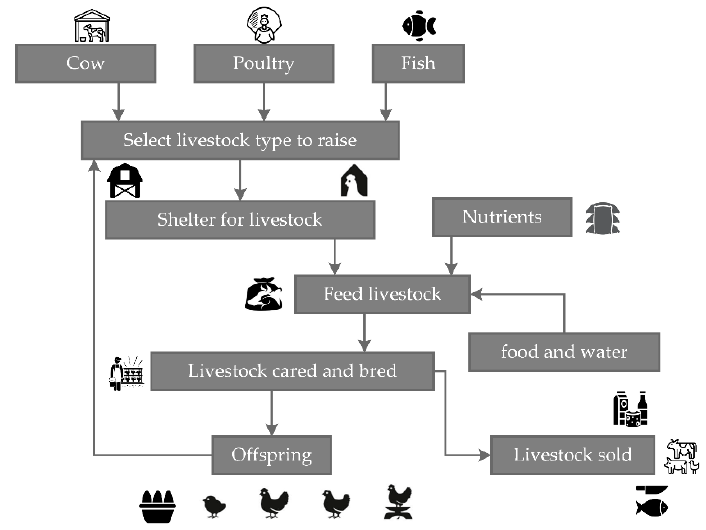
Figure 4. Conventional processes in animal husbandry.